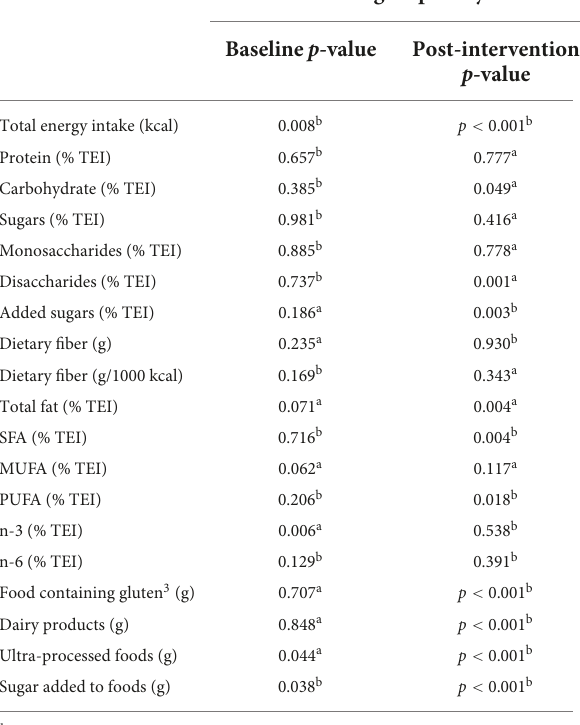
TABLE 3 Dietary intake between control and intervention group analysis at baseline 1 and post-intervention 2 . Outcomes Between-group analysis Baseline p -value Post-intervention p